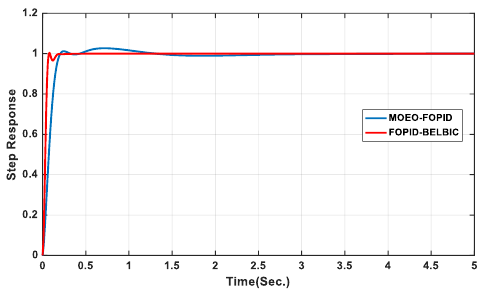
Figure 13. Step response of proposed controller and MOEO-PID/FOPID by considering uncertainty in